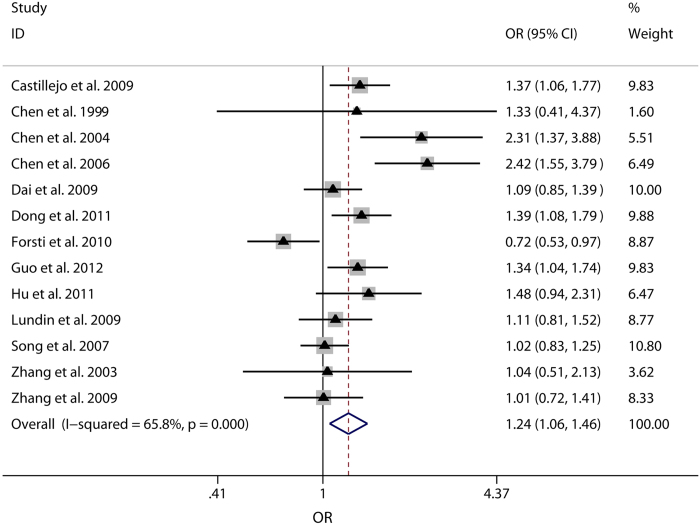
Forest plots of OR with 95% CI for Int7G24A rs334354 polymorphism and cancer
risk applying dominant model (GA + AA vs. GG).The triangles and horizontal lines correspond to the study-specific ORs and
95% CIs. The gray areas reflect the study-specific weight. The hollow
diamonds represent the pooled OR and 95% CI of the overall population. The
vertical solid lines show the OR of 1 and the vertical dashed lines indicate
the corresponding pooled OR.